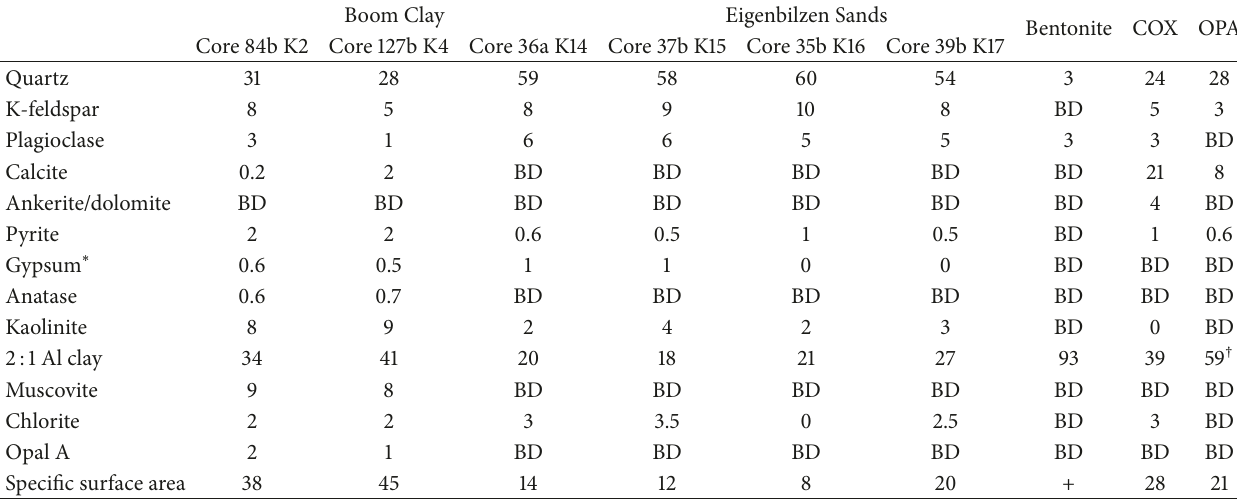
Table 2: Quantitative mineralogical composition of the different samples (in mass%) and the specific surface area (m 2 /g). Minerals which were below the detection limit are indicated with BD.